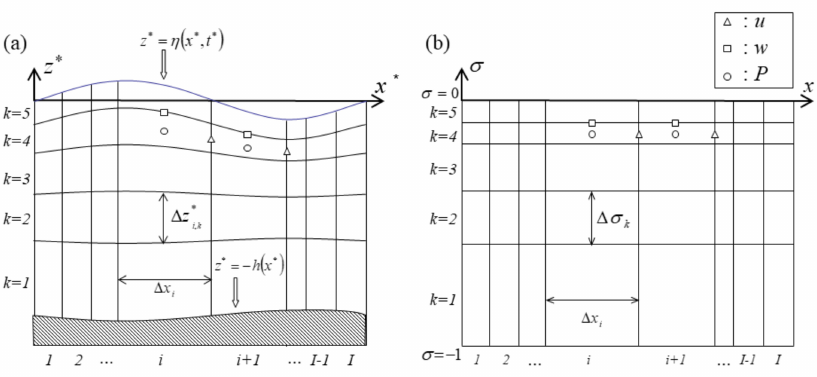
Figure 1. Mesh transformation and staggered variable arrangement between ( a ) a Cartesian co-ordinate and ( b ) a σ co-ordinate